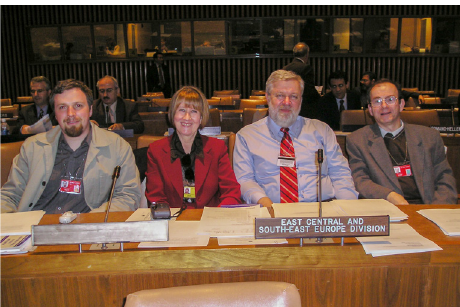
Fig. 5. 22nd Session of the United Nations Group